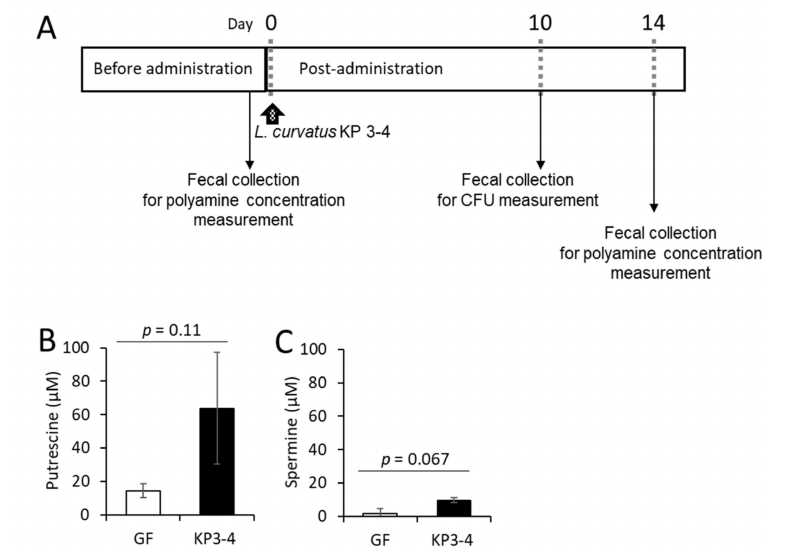
Figure 6. Effect of L. curvatus KP 3-4 colonization on polyamine levels in the intestines of mice. ( A ) The experimental schedule. Germ-free mice were administered L. curvatus KP 3-4 ( n = 3). The arrows indicate the timing of administration. ( B , C ) Concentration of putrescine ( B ) and spermine ( C ) in the feces of mice before and after the administration of L. curvatus KP 3-4. Data represent means ± standard deviation. The p value was calculated by paired t